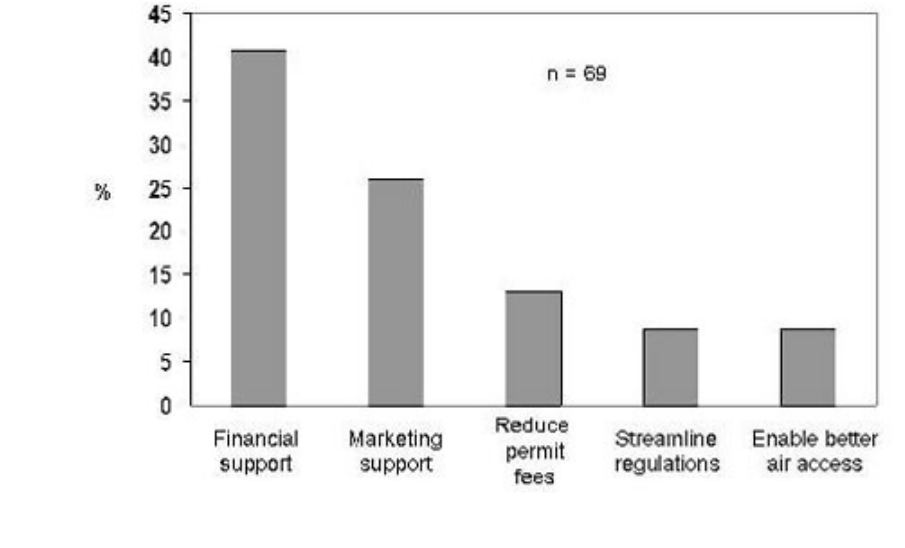
Fig. 2. Frequencies of suggested government interventions in a crisis scenario by reef tourism enterprises (41 enterprises, 69 intervention